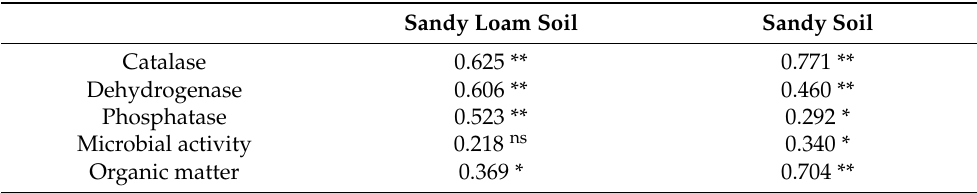
Table 3. Correlation coefficients of the linear relationships between organic matter, microbial activity, and enzymatic activities (catalase, dehydrogenase and phosphatase) with the root length under biostimulant condition from the two types of soils. Significance levels: ns, not significant; ** p < 0.01; * p <